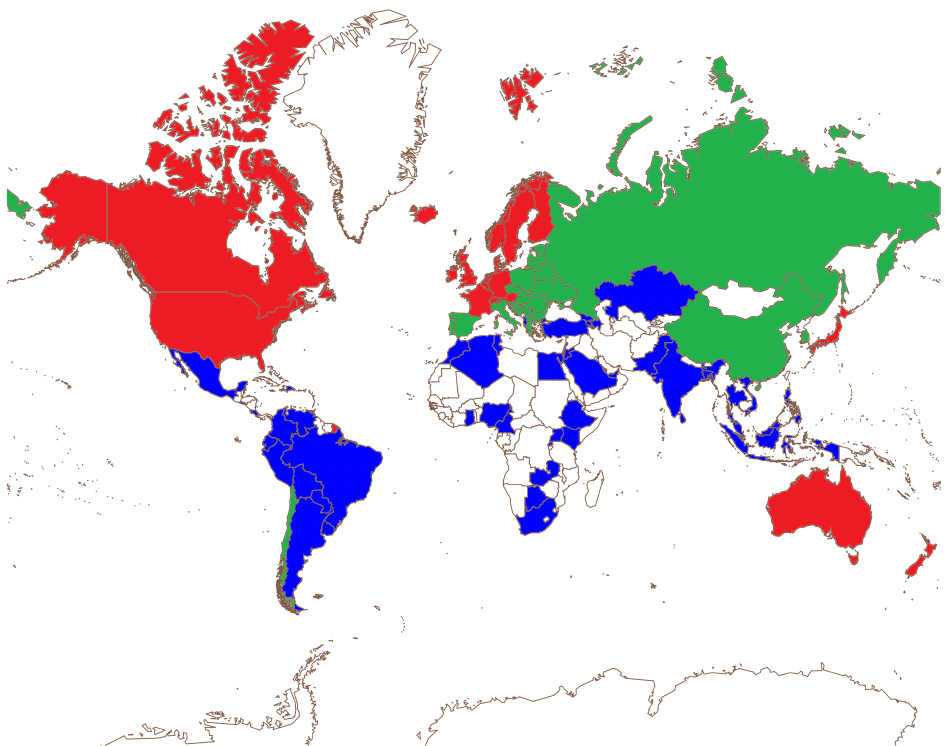
Figure 3. StartupBlink network communities. Communities of StartupBlink countries determined from the similarity network based on WDI indicators. Community I (red) contains 22 countries; community II (green) contains 27 countries; community III (blue) contains 51